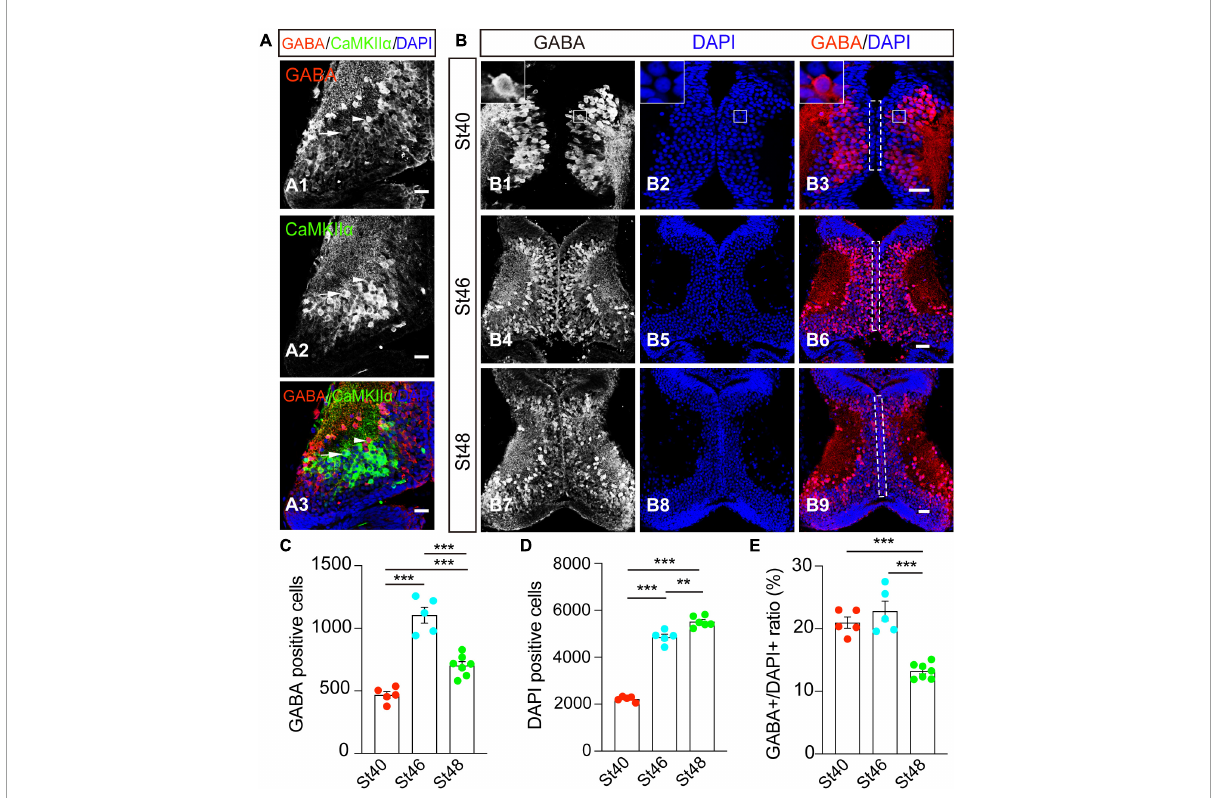
FIGURE1 GABA + cells are developmentally downregulated from stages 46 to 48 in the optic tectum. (A) The optic tectum was immunostained with anti-GABA and anti-CaMKII α antibodies at stage 48. Arrowheads indicate the GABA + and CaMKII α - cells. Arrows indicate the GABA - and CaMKII α + cells. Scale bar = 50 µ m. (B) The optic tectum was immunostained with an anti-GABA antibody at stages (St) 40 (B1–3), 46 (B4–6), and 48 (B7–9), respectively. The white line indicates the zoomed-in images that GABA is expressed in the cytoplasm (up-left corner, B1–3). The dotted line indicated the ventricular cell layer (B3,B6,B9). Scale bar = 50 µ m. (C) The data shows the total number of GABA + cells in the optic tectum. (D) The summary graph shows the total number of DAPI + cells. (E) The summary graph shows the ratio of GABA + cells to DAPI + cells. (GABA: St40, 468 ± 27.0, N = 5, St46, 1103.8 ± 62.9, N = 5, St48, 723 ± 28.7, N = 6; DAPI: St40, 2227.4 ± 48.9, N = 5, St46, 4859 ± 125.5, N = 5, St48, 5515 ± 91.9, N = 7; ** p < 0.01, *** p < 0.001). N represents the number of